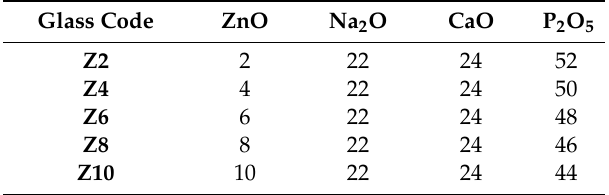
Table 1. Glass sample code and nominal glass composition